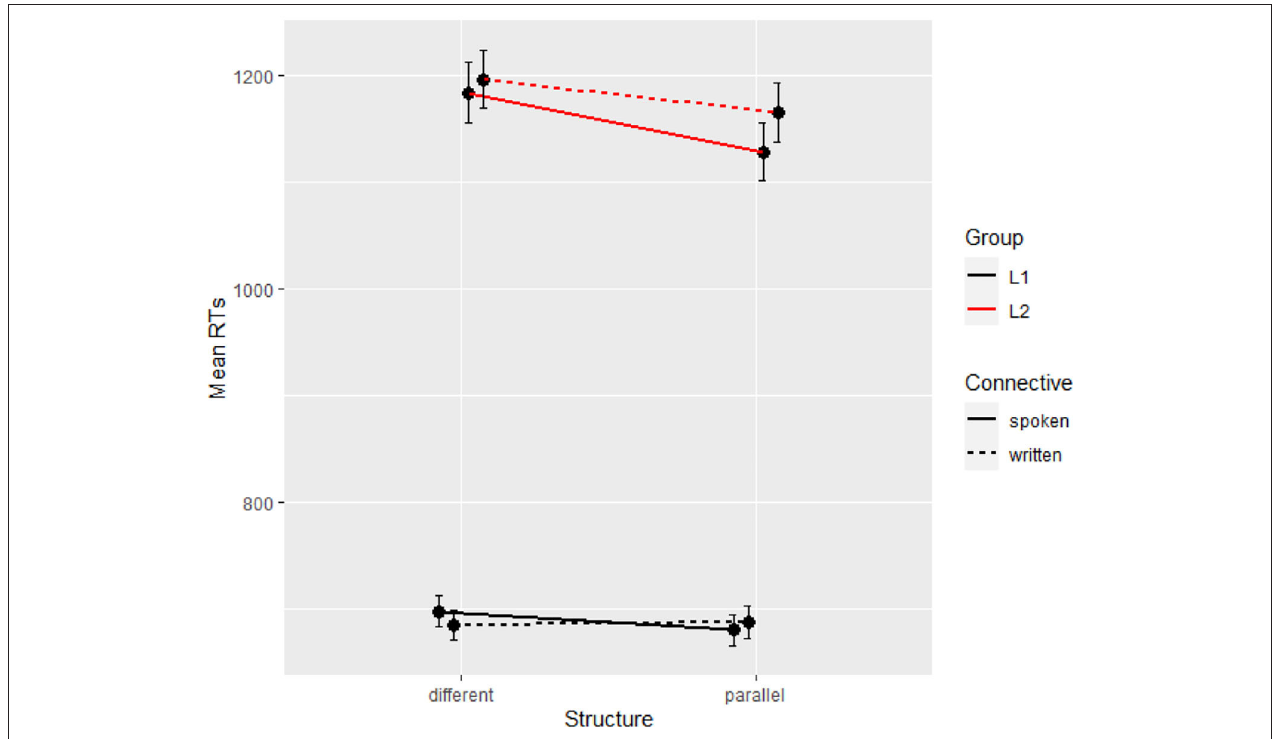
FIGURE 3 | Mean reading times per condition and per group (Experiment 2, segment